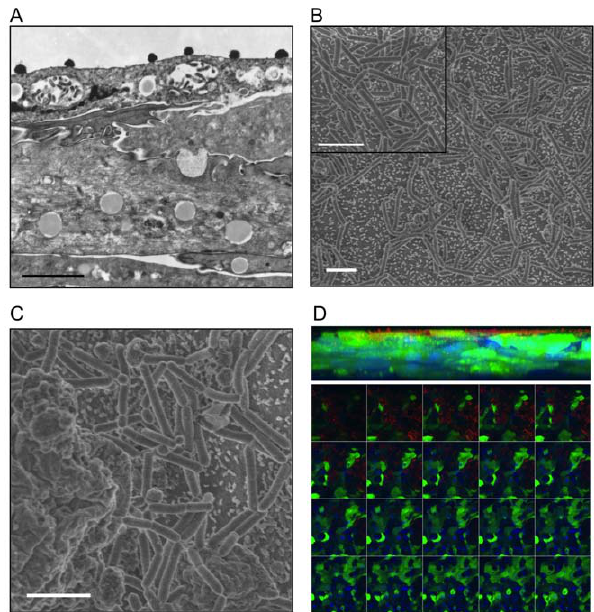
Figure 2. Commensal bacteria colonized the apical surface of air-interface VEC multilayer cultures. A . A representative trans- mission EM micrograph showing the top half of a VEC multilayer culture 24 h post colonization with L. jensenii on the apical surface illustrating the glycogen vesicles contained in the VEC that increased in size and density in the apical most layers of the cultures (bar=2 um; 14,100 6 ). B . Scanning EM micrographs illustrated the apical colonization of L. jensenii (24 h) and the intimate associations between bacteria and VEC microvilli present on the surface (bar=2 um; 3000 6 ). Apparent daughter bacterial cells with shorter length as well as areas of higher bacterial density were observed (inset panel). C . Commensal bacteria did not associate with the surfaces of cells that were condensed and apparently sloughing as indicated by their position above the average plane of the apical surface (e.g. cell left side of image; bar=2 um; 10,000 6 ). D . To confirm the location of the Lactobacilli colonizing the VEC multilayers, confocal Z-axis projection (63 6 ; top panel) and optical slices (bottom panels in order) from a GFP-expressing VEC multilayer (green) with DAPI stained nuclei (blue) and antibody labeled L. jensenii (red) illustrated exclusive superficial colonization of the apical cell surface. No evidence of bacteria (red labeling) in sections below the apical surface was obtained even after 72 h of colonization.